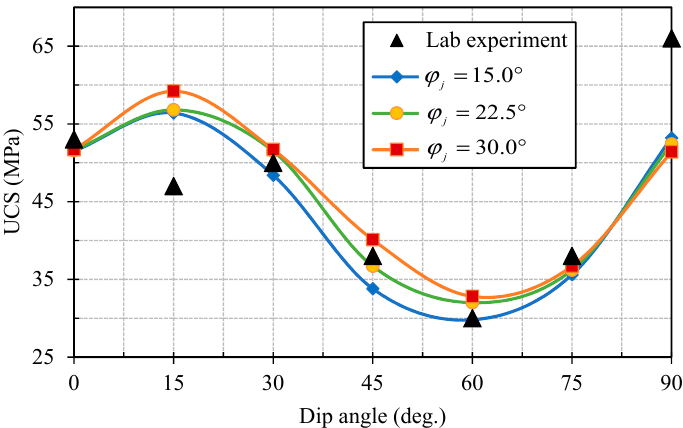
Figure 23. Strength variation of transversely isotropic rock samples with bonded joint friction angle.